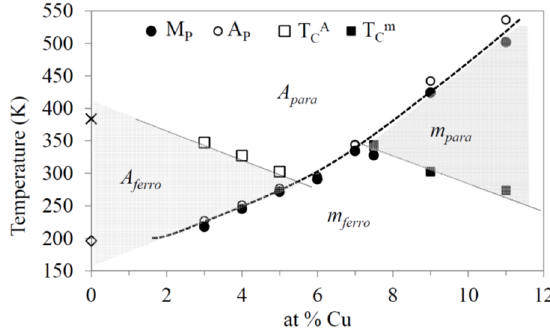
Figure 3. Temperatures of the magnetic and structural transitions as a function of x . The regions corresponding to different crystallographic and magnetic states of the alloys are indicated.